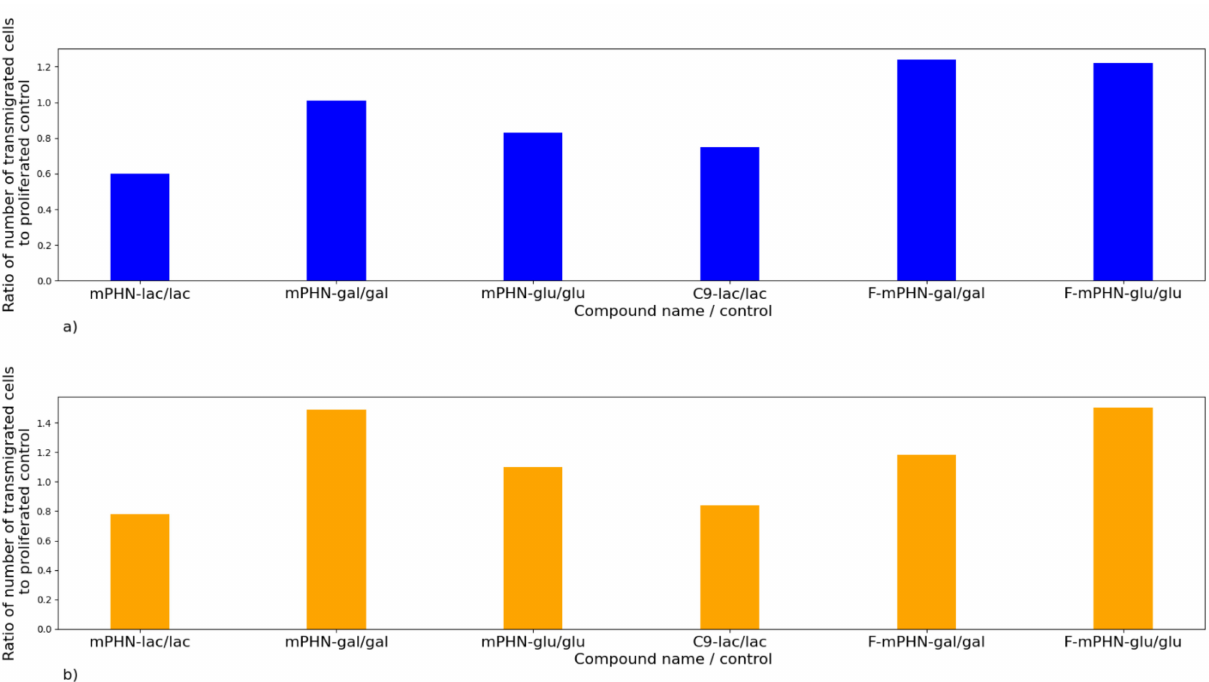
Figure 5. Transmigration assay of cancer cells in a presence of the investigated SFAE measured after 96 h. An increase in the ratio of proliferated cells after passing through the inserts, caused by the SFAE, may indicate that tested compounds could promote metastasis (at concentrations below the IC 50 ). A decrease in this ratio may indicate lack of such effect. ( a ) DU145; ( b )